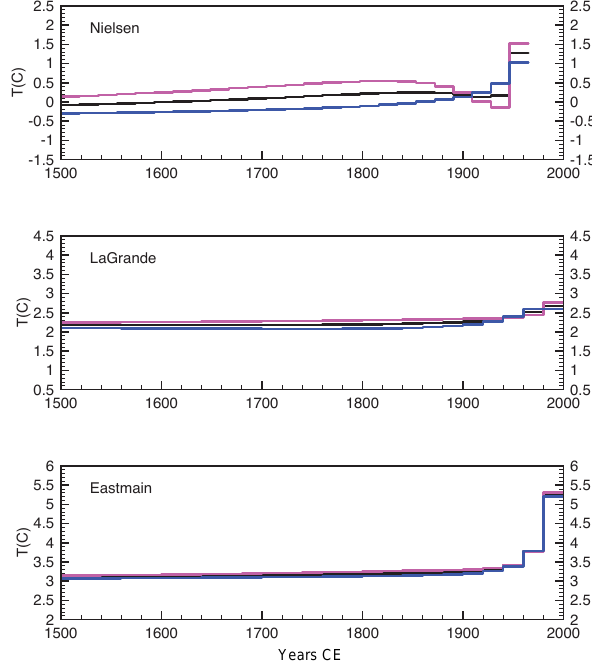
Figure 5. GST histories for the northern Québec sites. Simultane- ous inversion was used for Eastmain, which includes two holes. The pink and blue lines represent the inversions of the upper and lower bounds of the